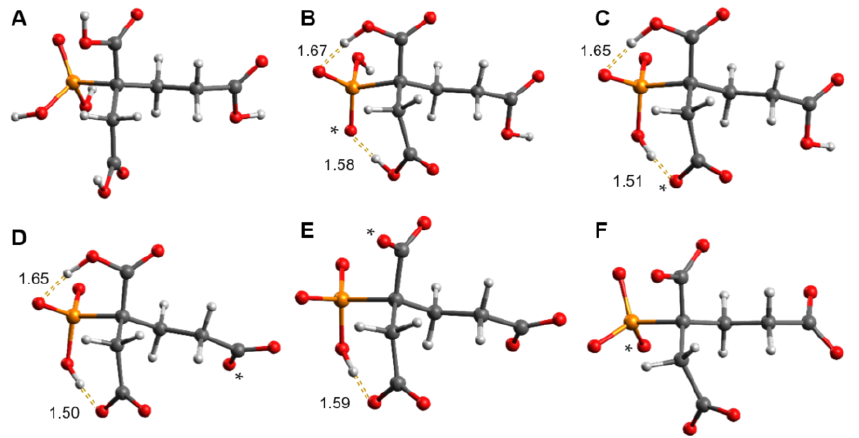
Figure 4. DFT-optimized structures of H n PBTC n − 5 species of lowest energy ( n = 5 through 0, corresponding to consecutive deprotonation, ( A – F ), respectively), according to Table 2. Sites of respective deprotonation are indicated by *. Dashed lines indicate intramolecular hydrogen bonds, with OH ⋯ O distances given in Å.